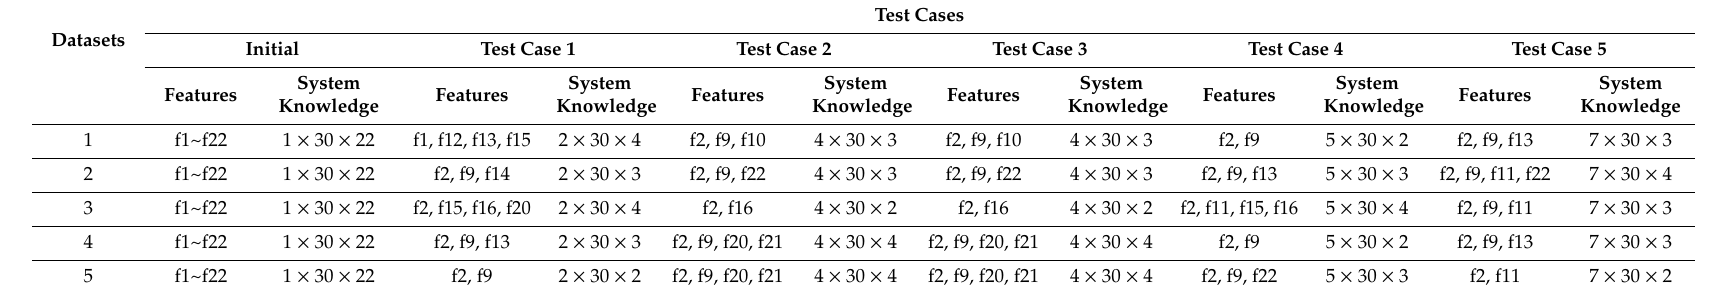
Table 3. Optimal feature vector for di ff erent test cases of di ff erent